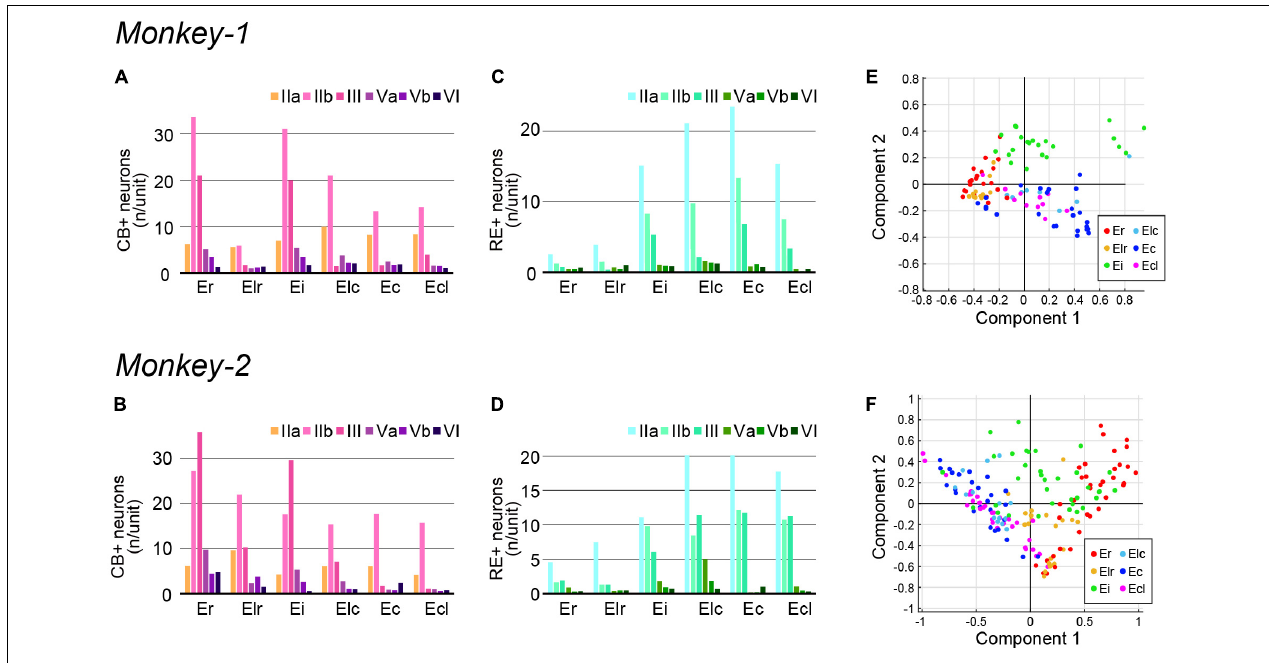
FIGURE 5 | Quantification of CB + and RE + neurons in monkey EC. (A–F) A diagram showing the number/unit of CB + neurons (A,B) and RE + neurons (C,D) in each EC subdivision across layers in Monkey-1 (A,C) and Monkey-2 (B,D) . (E,F) Principal component analysis based on the parameters shown in (A–D) (see section “Materials and methods” for detail). The plot shows the first two principal components, with both component 1 and 2 mainly representing the combined information from the five variables, CB + neurons in layer IIb and III, RE + neurons in layer IIa, IIb, and III, in Monkey-1 (E) and Monkey-2 (F)